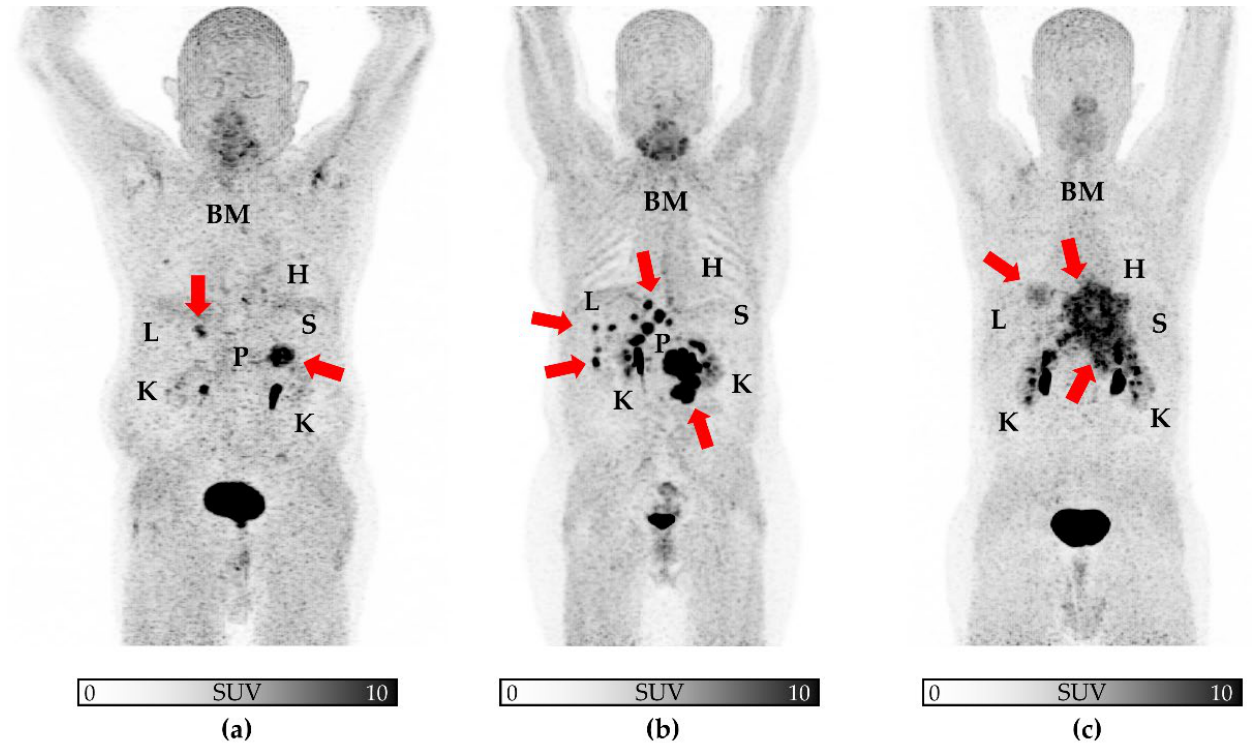
Figure 4. [ 68 Ga]Ga-FAPI-PETs in patients with low ( a ), intermediate ( b ), and high ( c ) tumor burden. Maximum intensity projections are shown, with arrows indicating tumor burden. Visually, normal organ uptake remain similar from ( a - c ) , supporting the notion that in patients with high tumor bur- den, uptake in normal organs does not drop. Given widespread disease in ( c ), the pancreas was not labelled. H = heart, L = liver, K = kidney, S = spleen, BM = bone marrow, P =